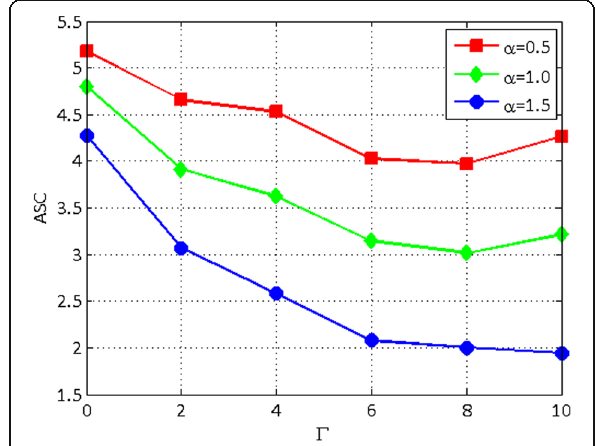
Fig. 27 Impact of Γ and Zipf parameter to ASC in ER model (d UE ¼ 4 ; N UE ¼ 60 ; T SBS